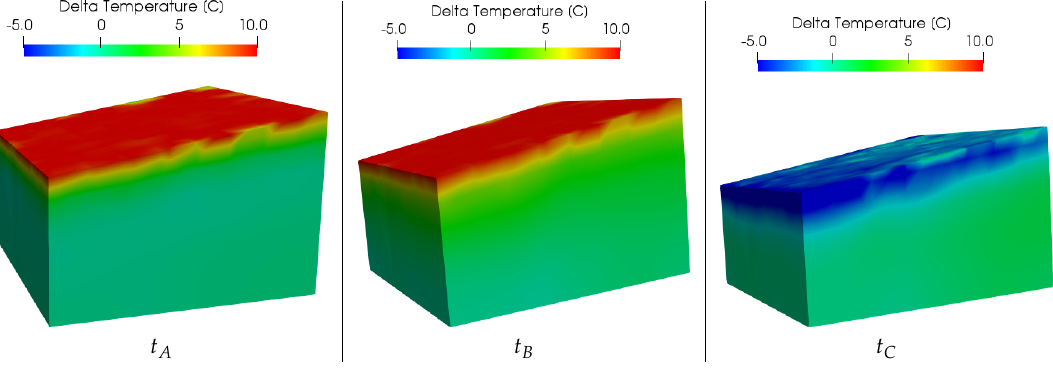
Figure 16. The difference of the temperature field at time t A = from that at t 0 =